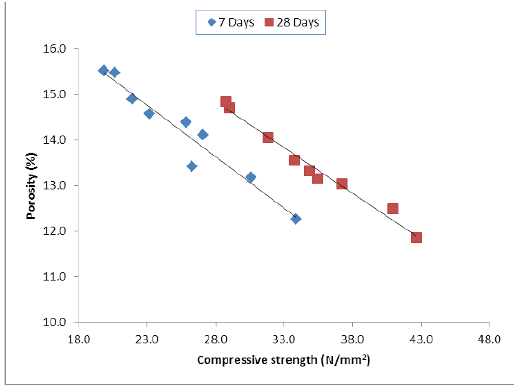
Figure 12. Relationship between compressive strength and poros- ity.